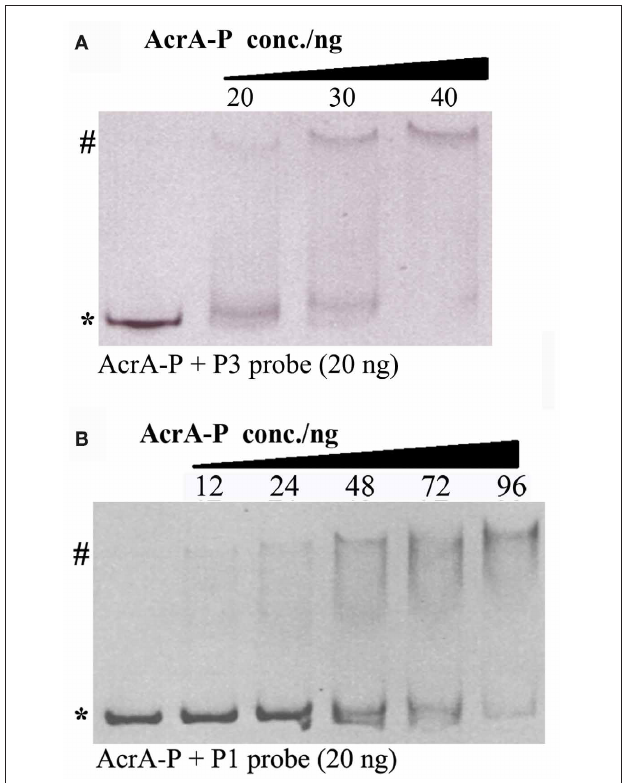
FIGURE 5 | Binding of ArcA-P to P1 and P3 promoters using EB stained EMSA assay. Various concentrations of AcrA-P were incubated with P3 (A) or P1 (B) . AcrA-P refers to phosphorylated His 6 -ArcA protein. Asterisk indicates free DNA probe and pound indicates protein–DNA